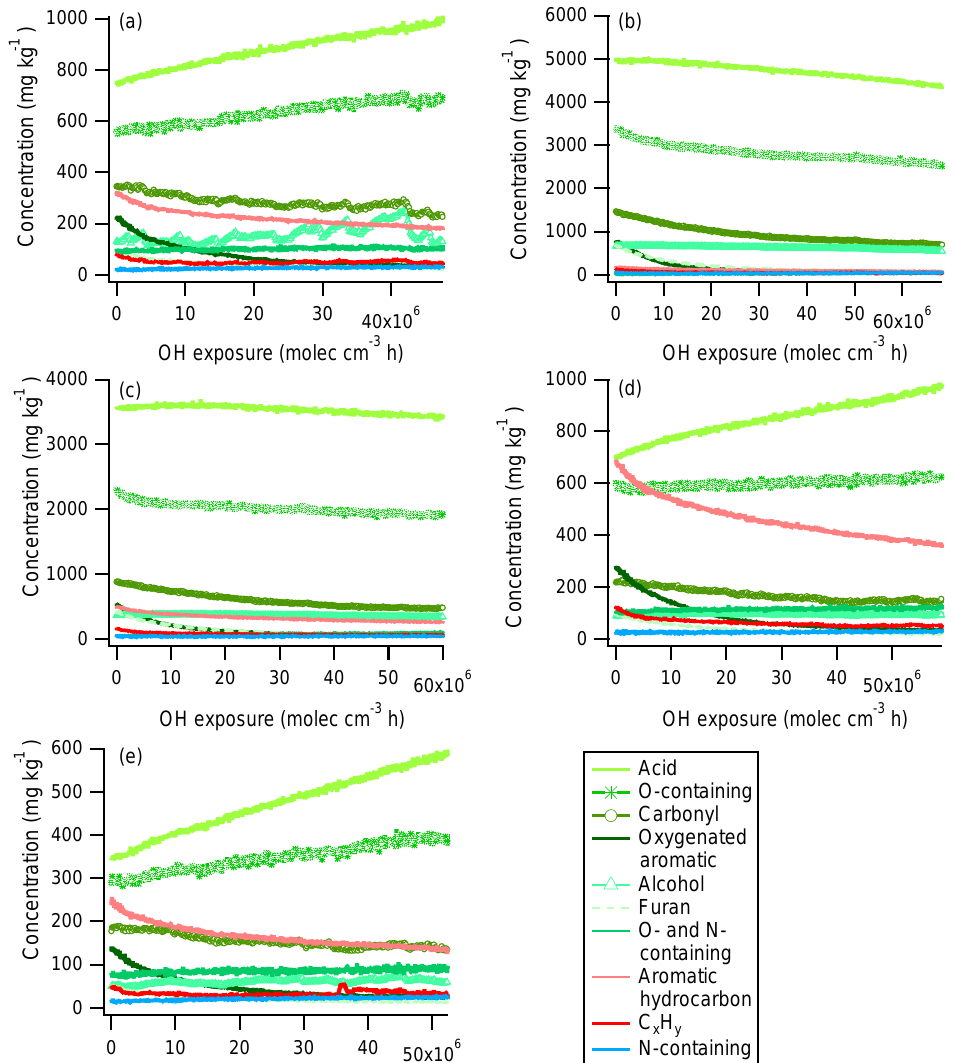
Figure 4. Temporal evolution of gas-phase species categorized by functional group throughout aging in the smog chamber for experiments 1–5 ( a – e ). Units on the y axes are mass of each functional group (mg) per mass of wood consumed